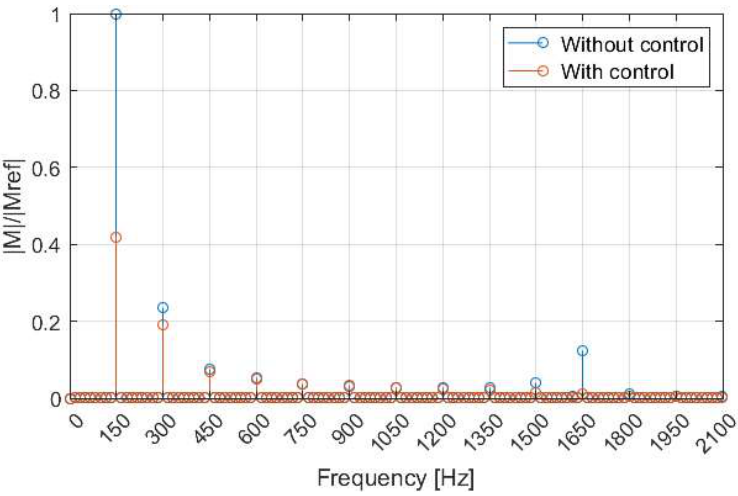
Figure 13. Ideal model. Delivery pressure FFT. Shaft speed 1000 r/min.